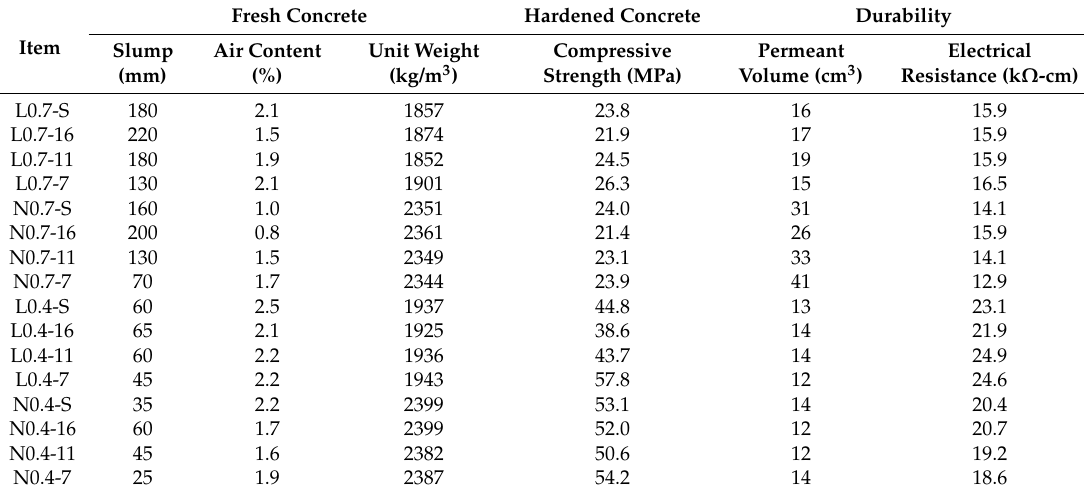
Table 5. Engineering properties of